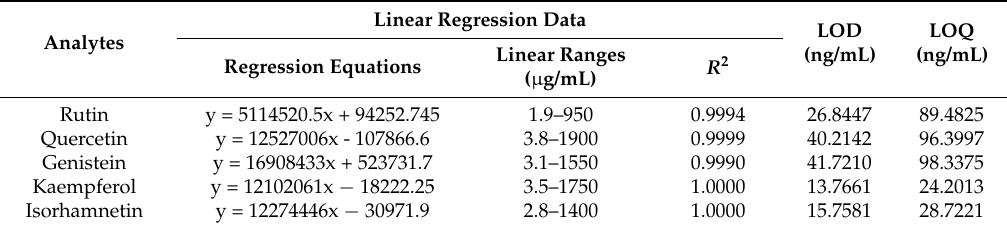
Table 6. Linear regression data, LOD, and LOQ of the investigated compounds.